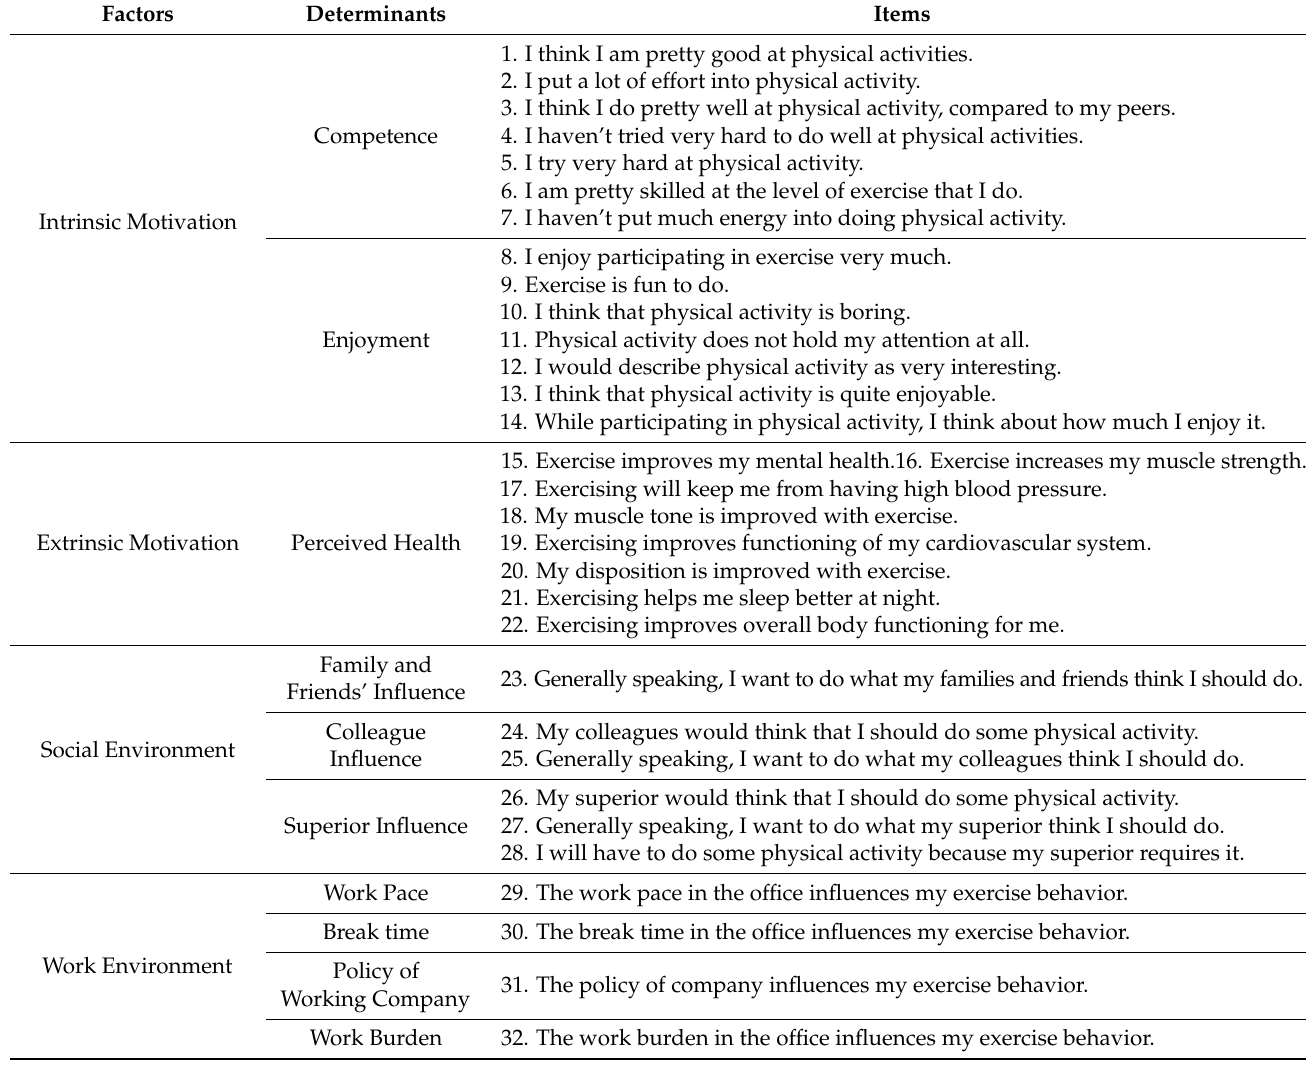
Table A1. The finalized 32-item Office Exercise Behavior Determinants